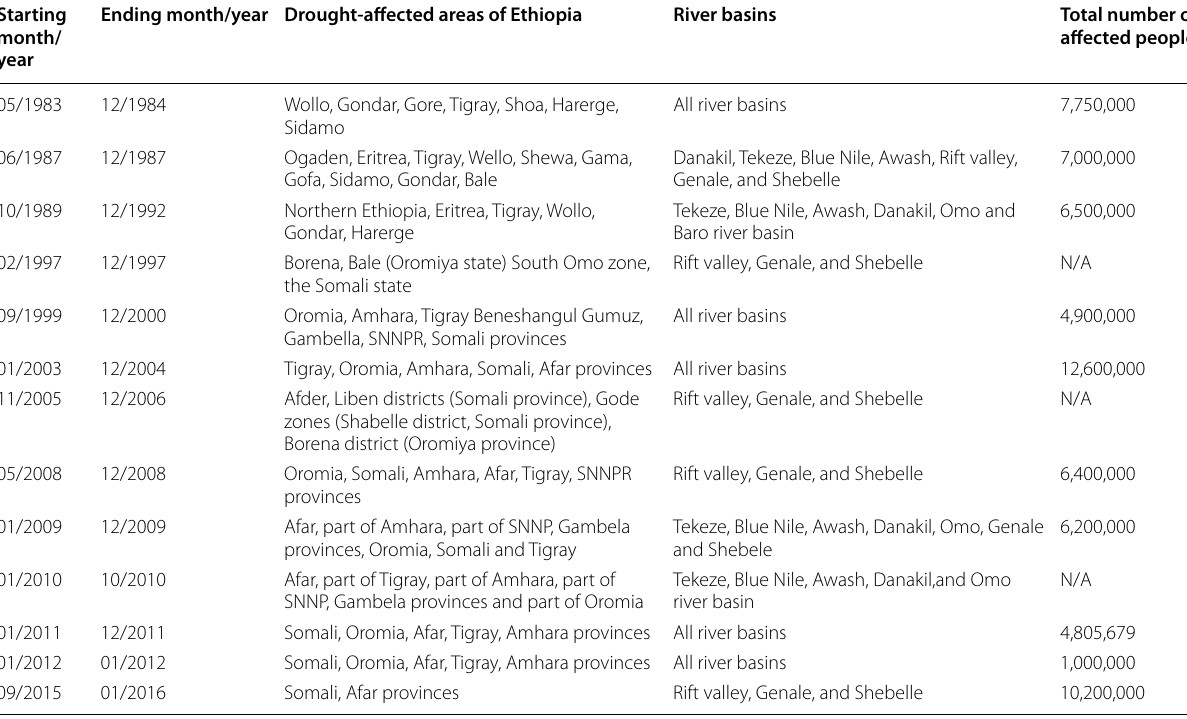
Table 2 Recorded Historical Droughts in Ethiopia ( Source: EM-DAT: www. emdat. be 2017) Starting Ending month/year Drought-affected areas of Ethiopia month/